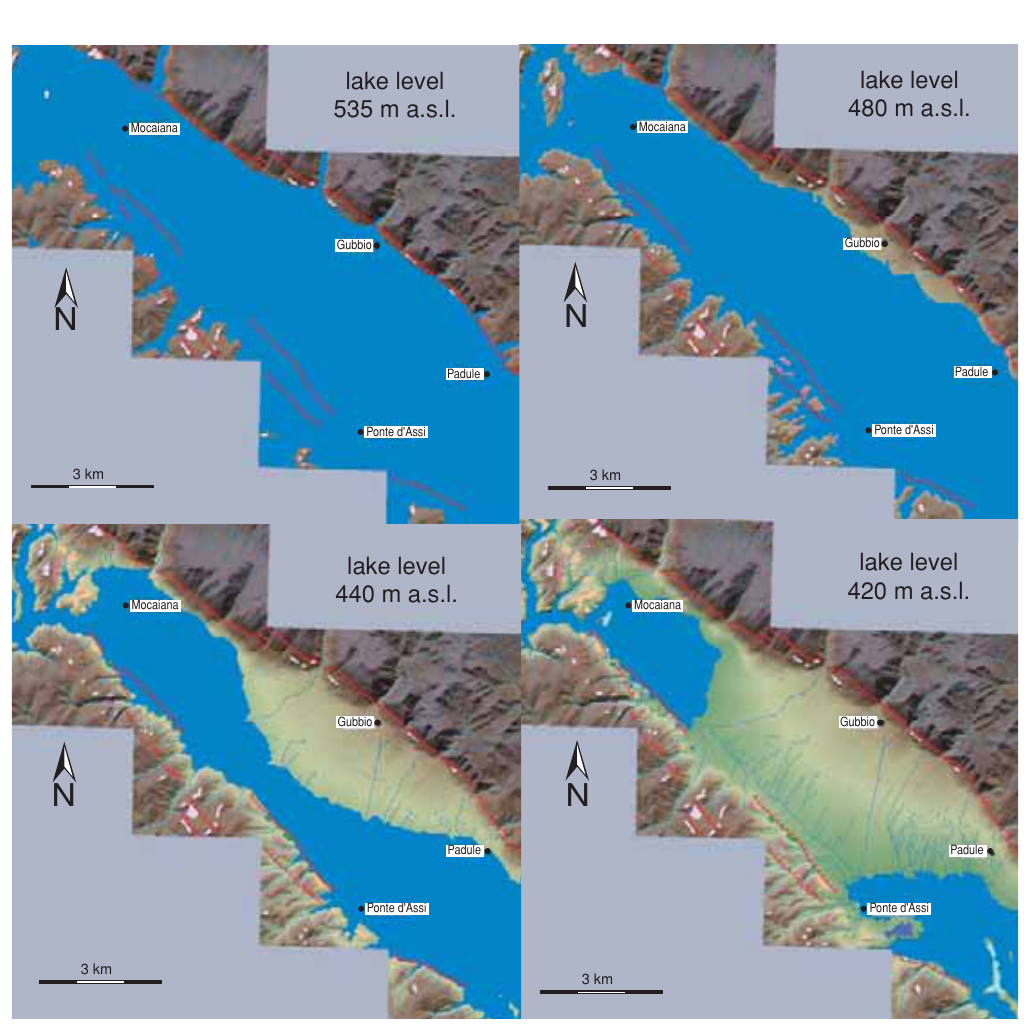
Fig. 13. Draining sequence simulation of the Gubbio Basin obtained by subsequently setting the lake level at 535, 480, 440 and 420 m a.s.l. See legend of fig. 6 for the reported paleosurfaces. Topographic base acquired from 5-m resolution